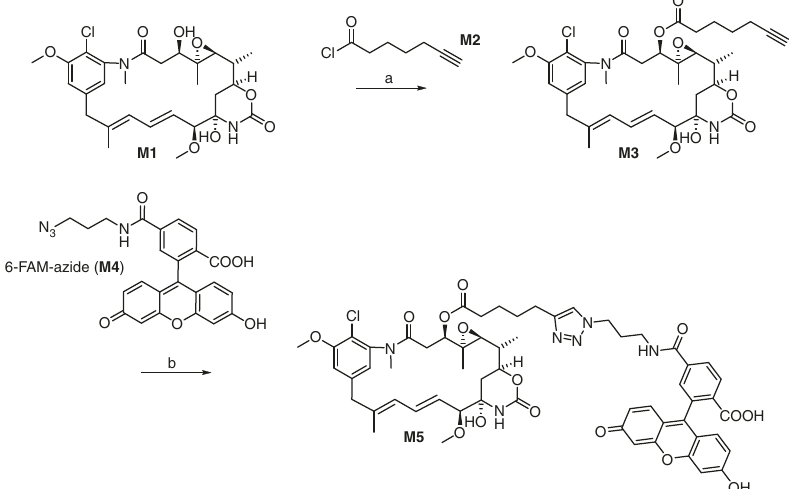
Fig. 1 Synthesis of FcMaytansine. a M2 , Et 3 N, 4-(1-pyrrolidinyl)-pyridine, rt, 7d, then prep. RP-HPLC, 20%; b M4 , CuSO 4 , Na-ascorbate, THF/H 2 0 4:1, 5 h, then prep. RP-HPLC,